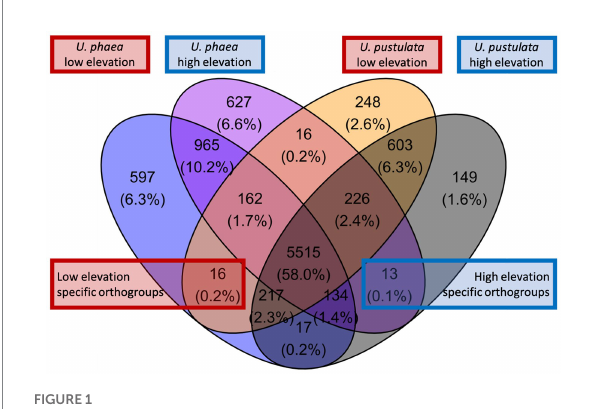
FIGURE 1 Venn diagram displaying orthogroups of U. phaea and U. pustulata . Red box highlights orthologs of the warm adapted (low elevation) U. phaea and U . pustulata genomes and the blue box of the cold adapted (high elevation)